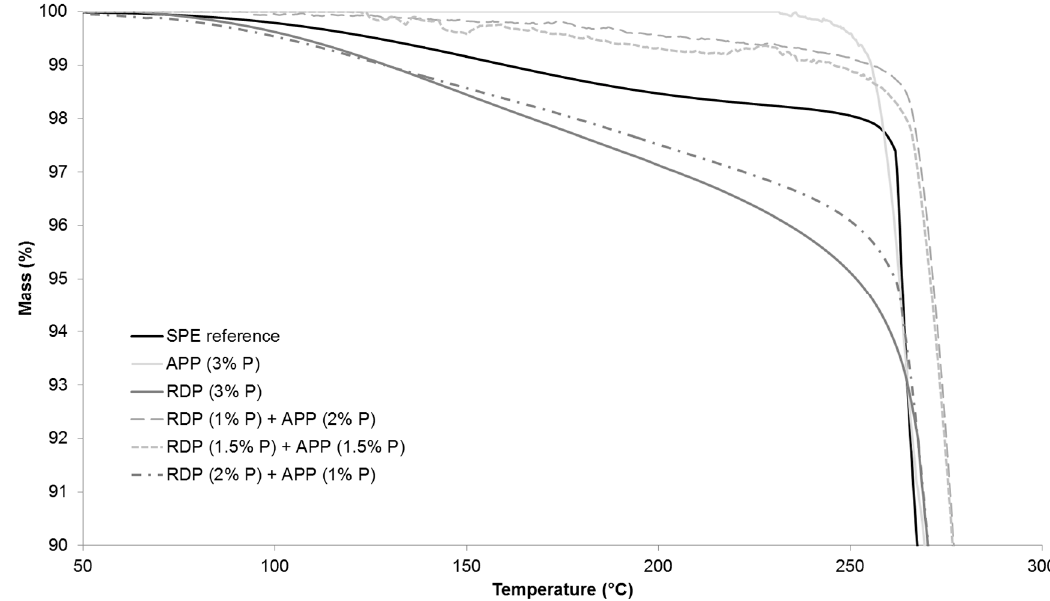
Figure 5. TGA curves of the reference and 3% P-containing SPE samples in the range of 50–300 °C.